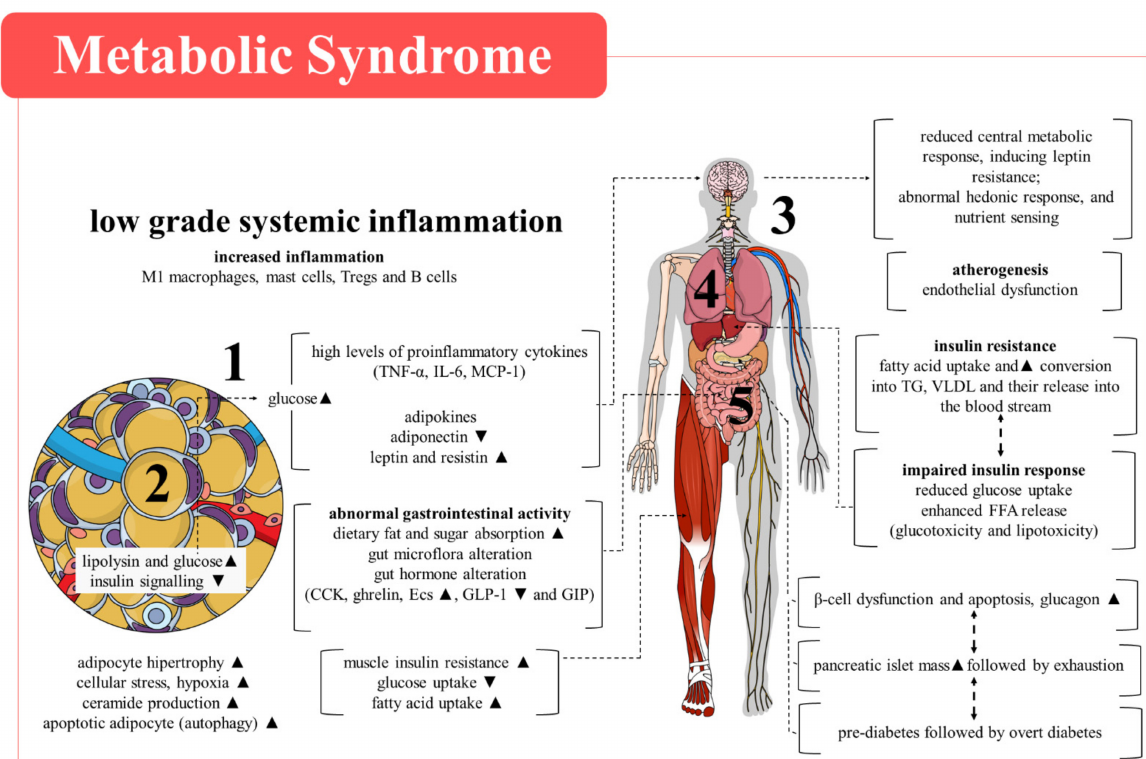
Figure 1. Mechanisms of metabolic syndrome (MS) pathophysiology. MS is a result of a metabolic imbalance which involves alterations in different tissues and a variety of molecules. (1) Insulin resistance is accompanied by (2) a low-grade inflammation in the adipose tissue characterized by reduction of adipokines such as adiponectin, enhanced levels of leptin and resistin, accumulation of inflammatory cells in the adipose tissue, paralleled with high levels of cytokines/chemokines and reactive oxygen species. Alterations of the central (hypothalamus and the brainstem) and peripheral mechanisms of hunger and satiety occur (3). All these events contribute towards (4) decreased energy expenditure, hyperglycaemia and dyslipidaemia, increasing the risk for type 2 diabetes and cardiovascular diseases. Nutrient absorption (5) and the gut microbiota play key roles in the modulation of MS, aiding the connection between the brain and metabolic tissues. TG—triglycerides; VLDL—very low-density lipoprotein; CCK—cholecystokinin; Ecs—estrogens; GLP-1—glucagon-like peptide-1; GIP—gastric inhibitor peptide; TNF α —tumour necrosis factor α ; IL-6—interleukin-6; MCP-1—macrophage chemotatic